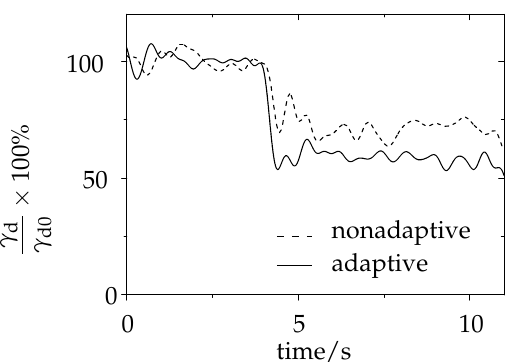
Figure 9. Experimental results for the angular drift of the rotor orientation